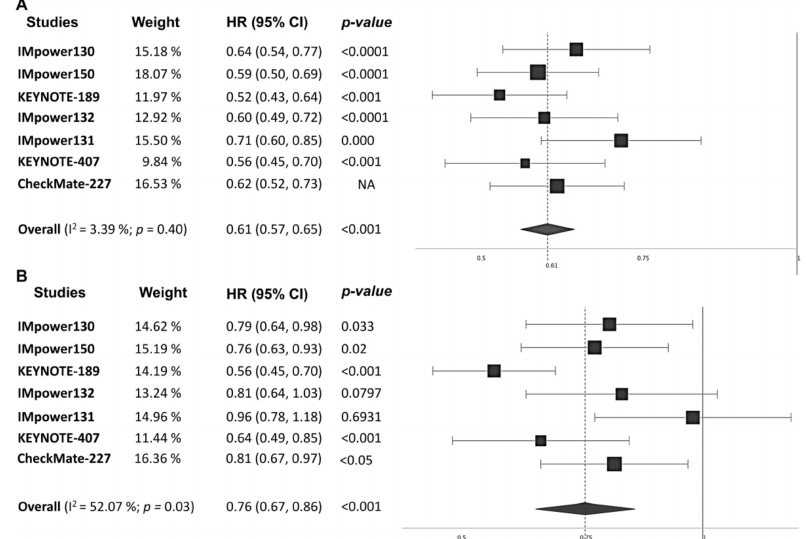
Figure 2. Forest plot of pooled hazard ratios for ( A ) progression-free survival (PFS) and ( B ) overall survival (OS) in patients who received programmed cell death-1 (PD-1) / programmed death ligand-1